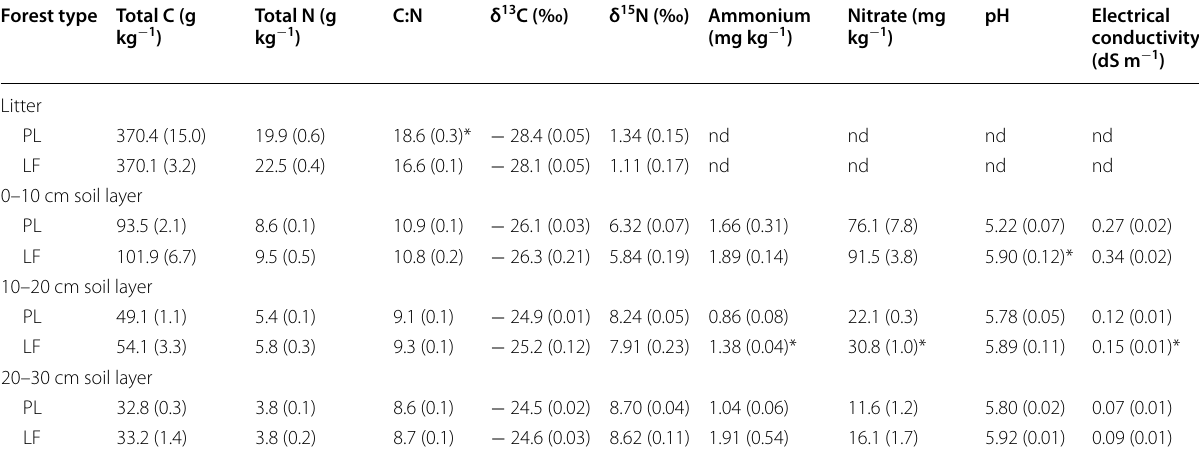
Mean values for n 3 are presented. PL, monoculture L. gmelinii plantation; LF, mixed L. gmelinii – F. mandshurica plantation = * Represents significant differences between the monoculture and mixed plantations at the P < 0.05 level